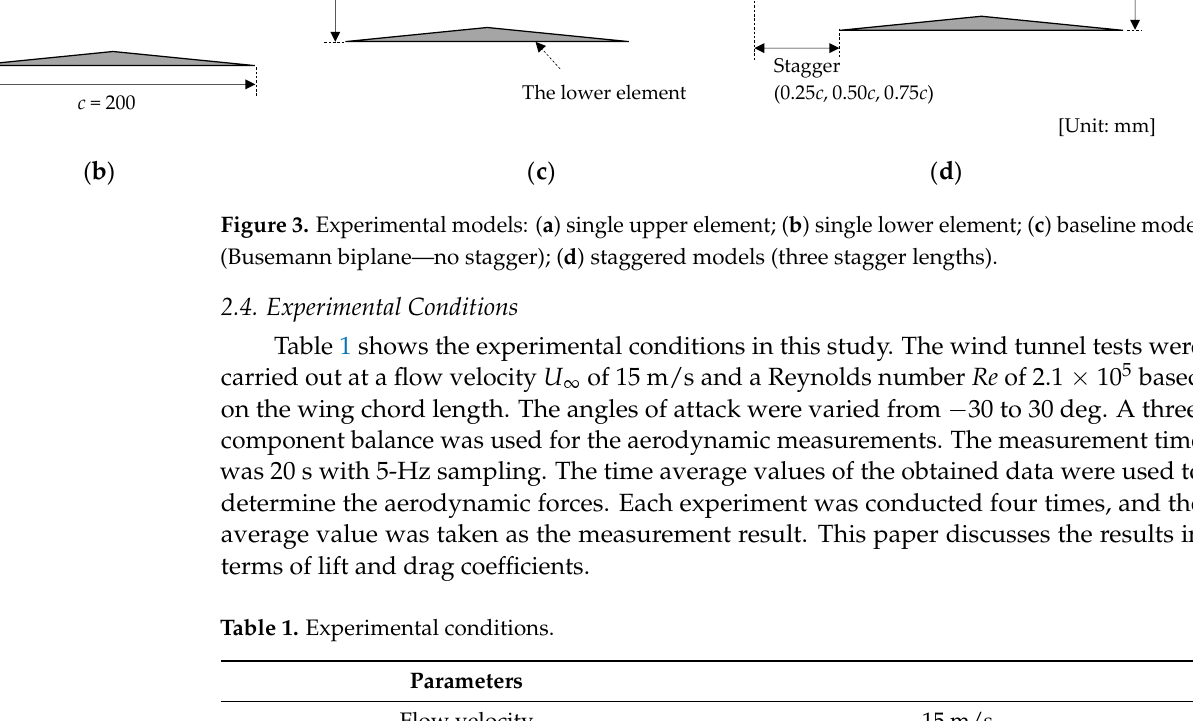
Table 1. Experimental